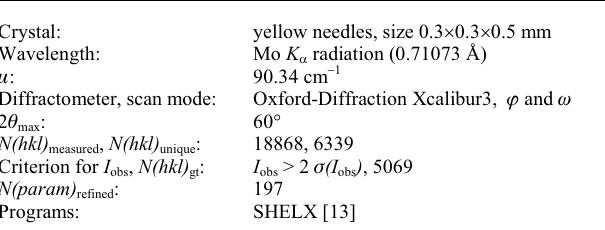
Table 1. Data collection and